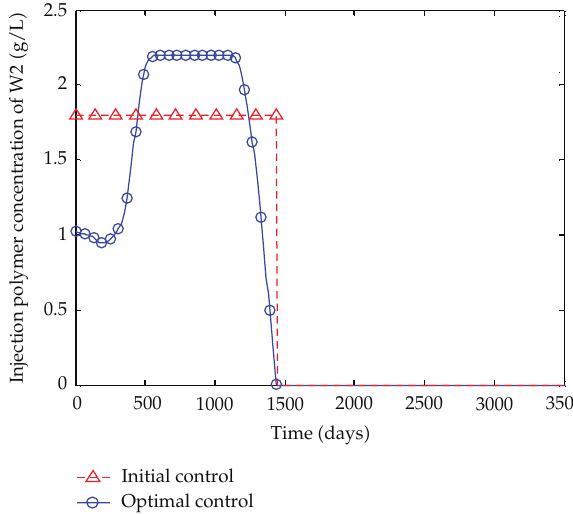
Figure 5: Injection polymer concentration of well